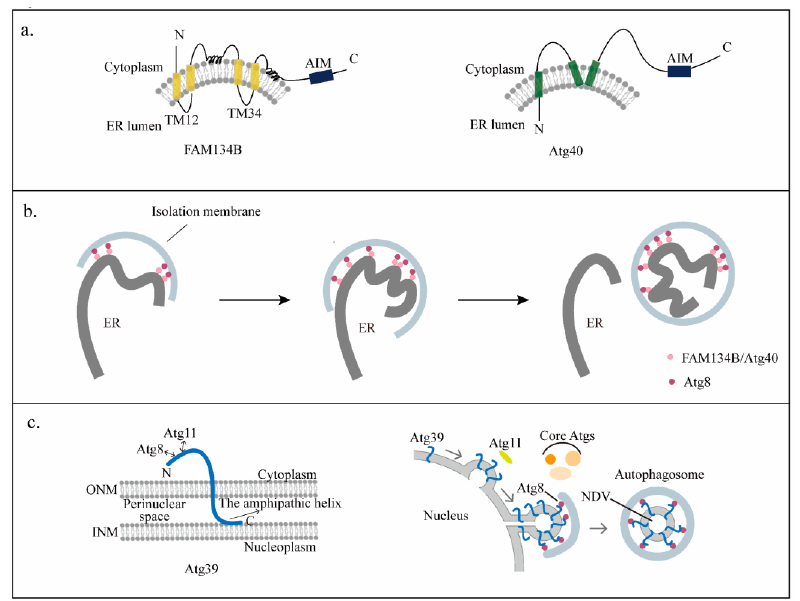
Figure 3. The models of ER-phagy and nucleophagy. ( a ) The structure of FAM134B and Atg40. Left: TM12 and TM34 anchor to the ER membrane, and two amphipathic helices position on the membrane on either side of TM34 to induce membrane curvature. Right: There are three transmembrane domains that like the reticulon domain induce the production of highly curved ER fragments. ( b ) A model for local ER remodeling by FAM134B/Atg40 in ER-phagy. When IM formation initiates in the vicinity of the ER, FAM134B/Atg40 induces membrane curvature, and then the AIM domains of FAM134B/Atg40 interact with Atg8 on the IM to wrap these fragments into the IM, leading to efficient ER packing of the IM. ( c ) Atg39 is anchored to the ONM via the single-pass membrane domain, and it is associated with the INM via the amphipathic helices of the C-terminal. When nucleophagy is induced, the amphipathic helices of Atg39 promote the assembly of Atg39 at the NDV formation site, and are also involved in the deformation of the nuclear envelope.